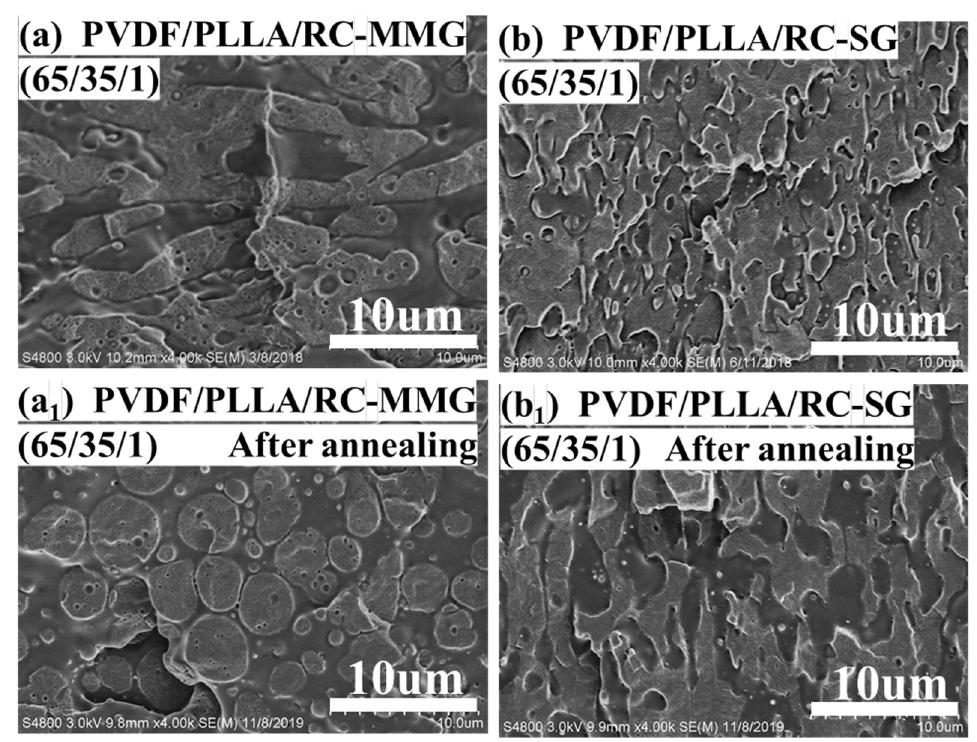
Figure 4. SEM images of PVDF / PLLA (65 / 35, w / w) blends with 1 wt.% RC–MMG ( a , a 1 ) or RC–SG ( b , b 1 ) before and after annealing.